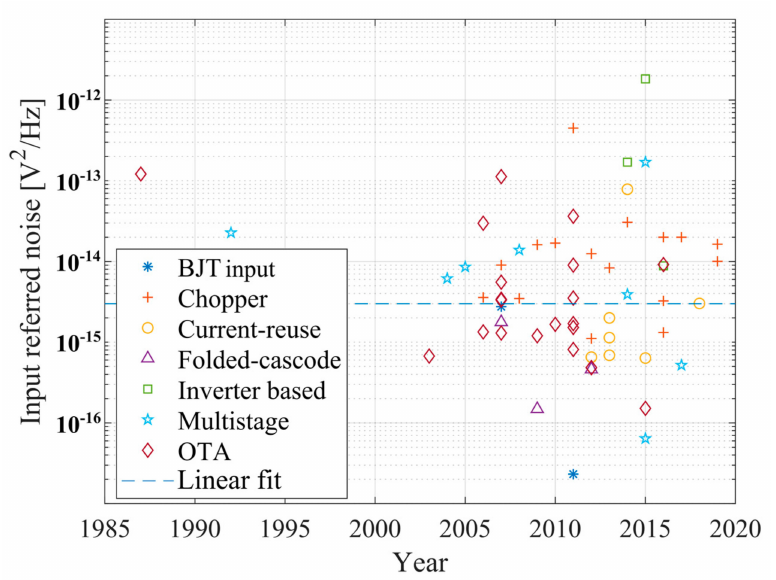
Figure 3. Average squared and integrated IRN of the amplifier topologies divided by their bandwidth. The dashed line is the best linear fit through all data points on the logarithmic